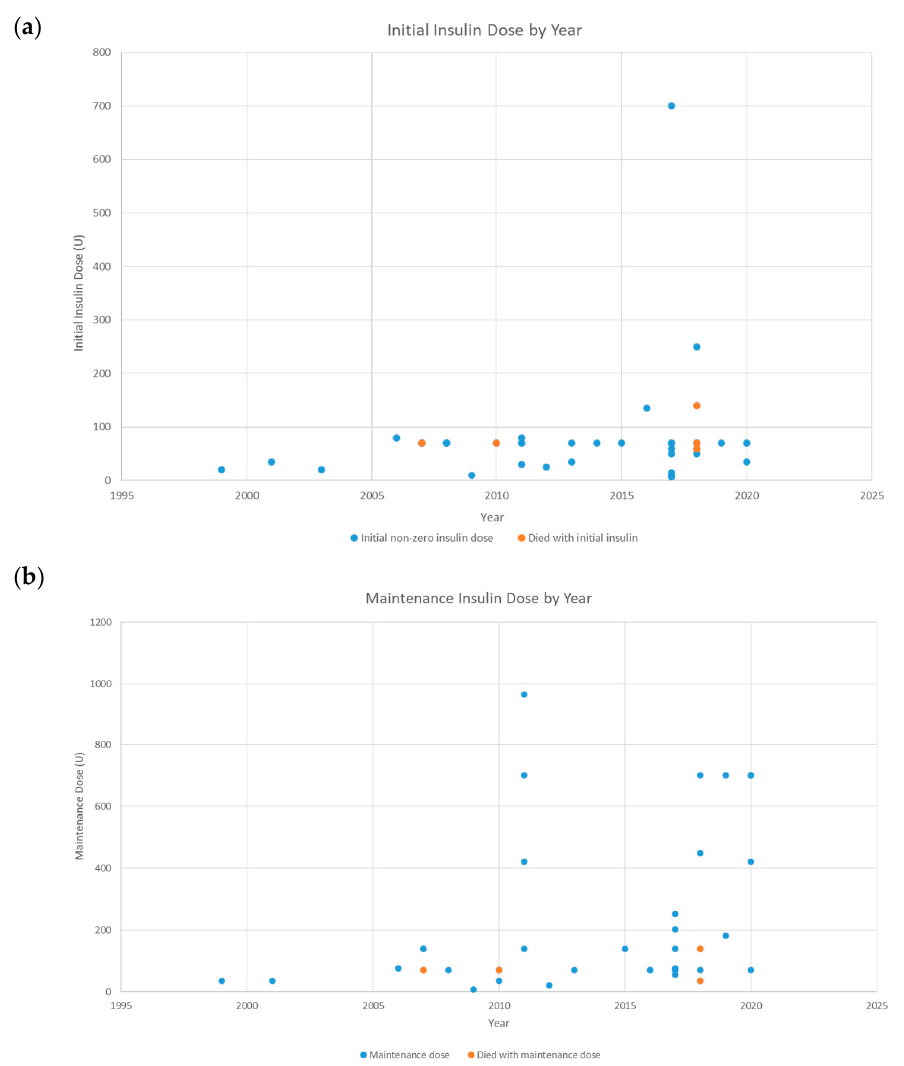
Figure 1. Regular Insulin Dosing. ( a ). Initial insulin dose by year ( b ). Maintenance insulin dose by year.